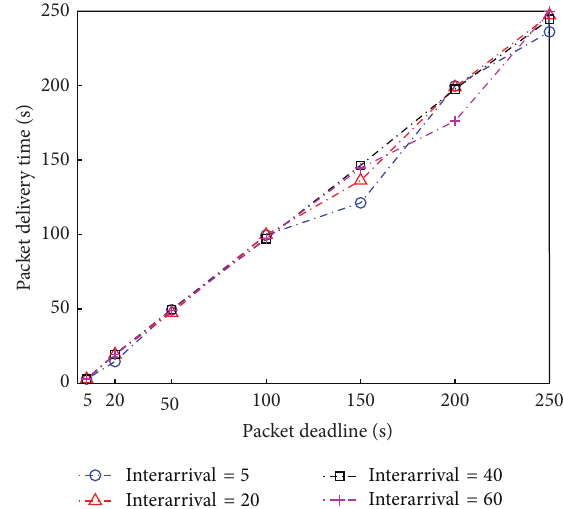
Figure 5: Routing cost with respect to packet deadline and mobile nodes’ interarrival time.